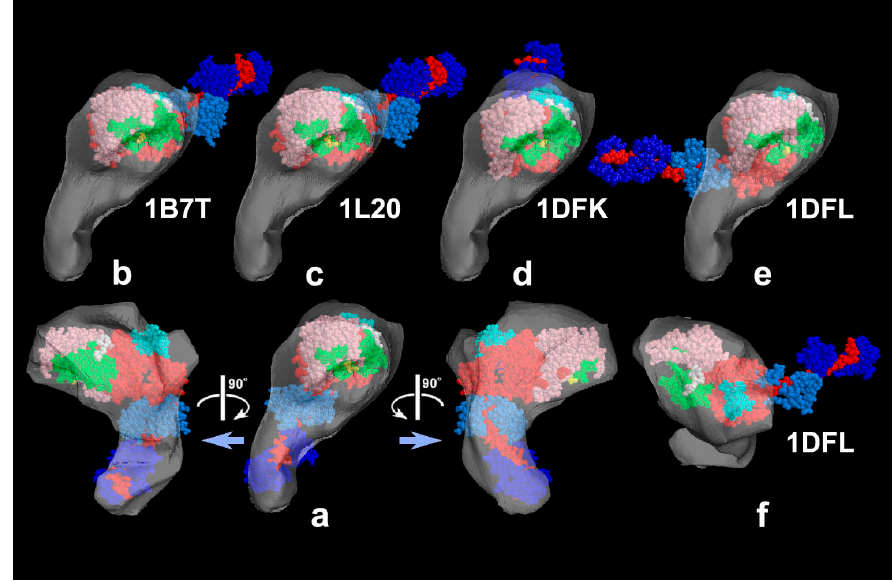
Figure 3. Reconstructed shell to present the 3D envelope of the SH1–SH2 cross-linked myosin head (reproduced from [33]). ( a ) Its tentative model was fitted to the shell and viewed from four different angles; ( b – f ) Four known crystal structures of scallop–S1, whose catalytic domains are snugly placed in the shell of the novel structure. Note that the orientation of the lever arm in the novel structure is directed quite differently from the others. The atomic models are: ( b ) ADP-bound form, ( c ) ADP-bound Lys705-Cys693 cross-linked form, ( d ) nucleotide-free near-rigor form, ( e , f ) ADP/Vi-bound form seen from opposite side. Subdomains of myosin S1 are color-coded as follows (upper-50 KDa, pink-tint; lower-50 KDa, green; N-terminal barrel, cyan; essential light-chain, sky-blue; regulatory light-chain, blue; 1st actin-contact site; yellow; 2nd actin-contact site, white; remaining part of heavy-chain including the lever-arm, red).